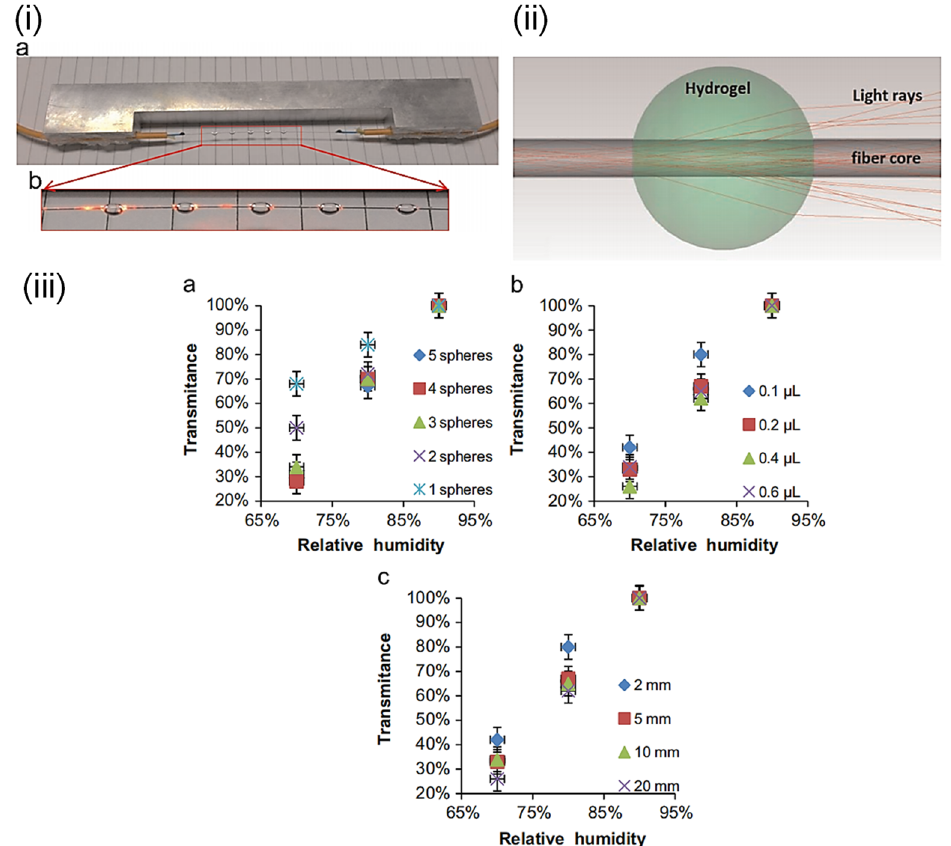
Figure 22. Point sensor. ( i ) Photograph of the sensor head array, ( a ) The sensor head; ( b ) magnified view of the five spheres with light input from the left side. Bright spots away from hydrogel spheres along fiber core are due to slight damage to the core surface during fabrication. ( ii ) Conceptual design of each sensing node. ( iii ) Influence of ( a ) sphere number, ( b ) size, and ( c ) separation space on the optical response. Adapted with permission from ref. [105]. Copyright 2015 Elsevier